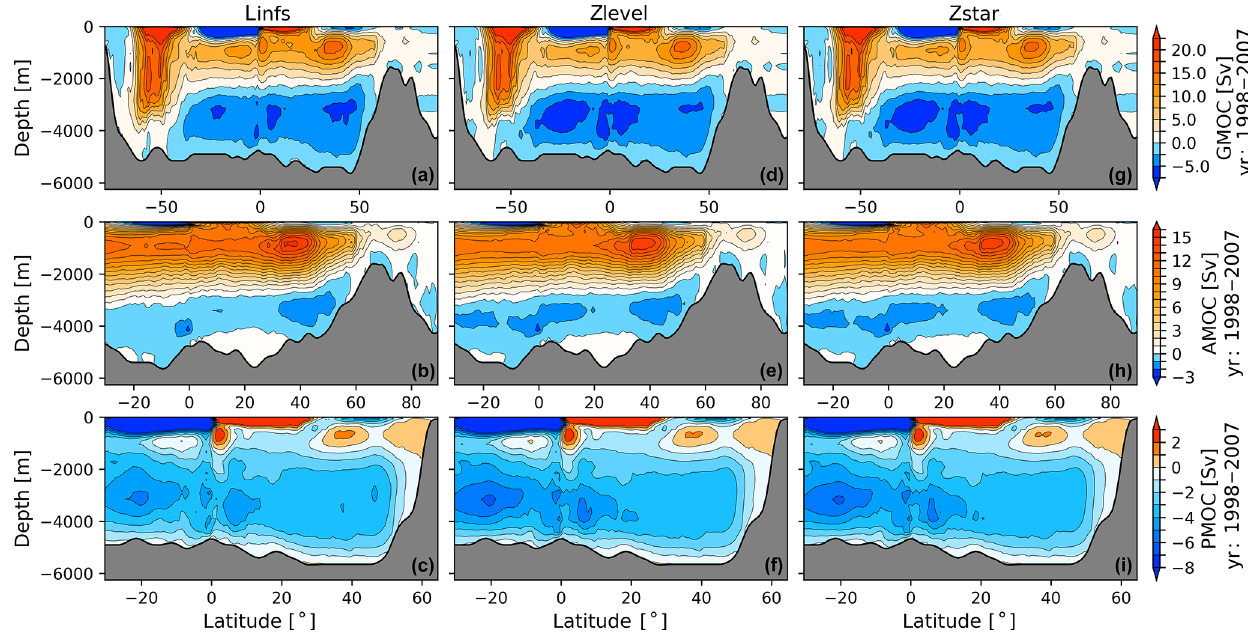
Figure 5. Global (GMOC, a, d, g ), Atlantic (AMOC, b, e, h ) and Indo-Pacific (PMOC, c, f, i ) meridional overturning circulations for the linear free-surface formulation linfs (a–c) and the full free-surface zlevel option (d–f) and zstar option (g–i) . The average over the time period of 1998–2007 is shown. Note that different color ranges are